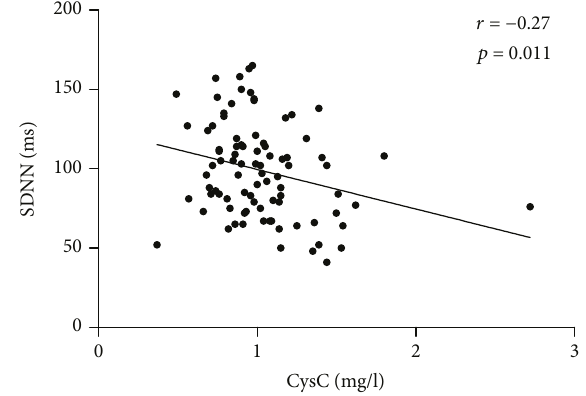
Figure 4: Relationship between cystatin C (mg/l) and SDNN (ms) in subjects over 60y. Correlation assessed by Pearson